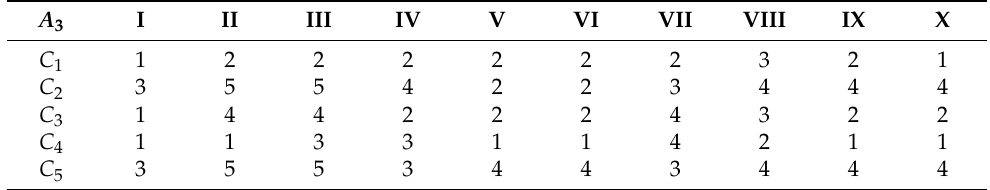
Table 4. Ratings of alternative A 3 in relation to the evaluation criteria obtained from 10 respondents.